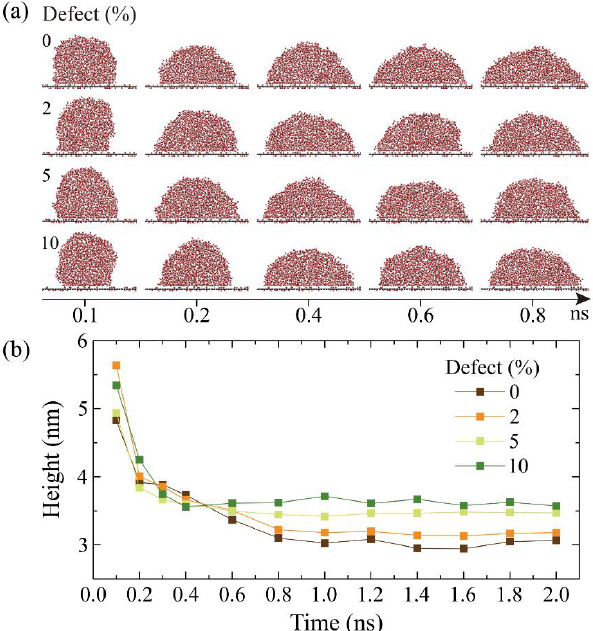
Figure 3. ( a ) Simulation snapshots of a water droplet during the wetting process on different surface vacancy defect concentrations. ( b ) Evolution of the height of the droplet in the simulation.